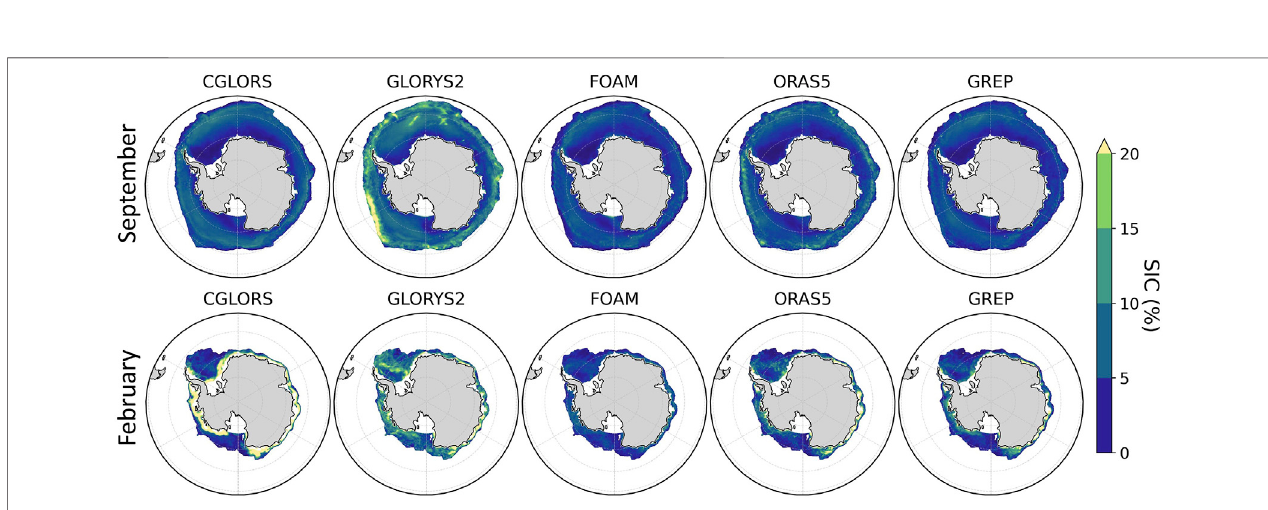
FIGURE4| Meanrootmean square errorforSIC at everygrid cellforthesingleORAsand GREP against CDRinSeptember(upperrow)and February (lowerrow).